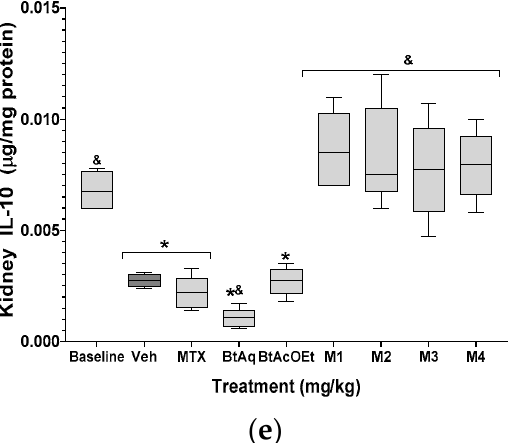
Figure 6. Effect of different treatments obtained from the B. ternifolia root extract on the inflammatory response ( a ) IL-17, ( b ) IL-1 β , ( c ) IL-6, ( d ) TNF- α and ( e ) IL-10 of the kidneys of mice with experimental arthritis. The aqueous extract BtAq and the ethyl acetate extract BtAcOEt were derived from the bipartition of the complete extract. Fractions M1, M2, M3, and M4 were obtained from BtAcOEt. ANOVA with post hoc Tukey test, with * p < 0.05 compared with baseline group, & p < 0.05 compared with Veh group ( n = 7 ± SD).